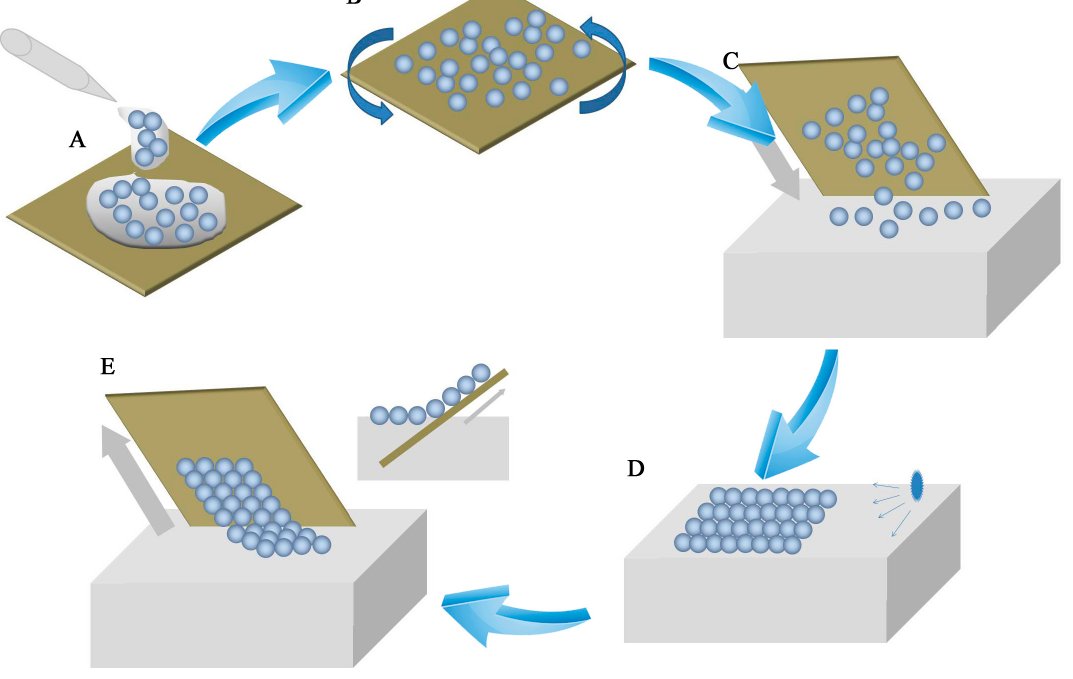
Figure 1. Schematic diagram of the air-water interface self-assembly method. ( A ) Drops of solution were applied on the wafer surface; ( B ) the wafer was spun to achieve a colloidal microsphere film; ( C ) the wafer with polystyrene (PS) microspheres was dipped slowly into deionized (DI) water. PS microspheres floated on the water surface; ( D ) PS microspheres self-assembled on the air-water interface when the surface tension was changed by using SDS; ( E ) a high-order colloidal crystal was transferred to the substrate.